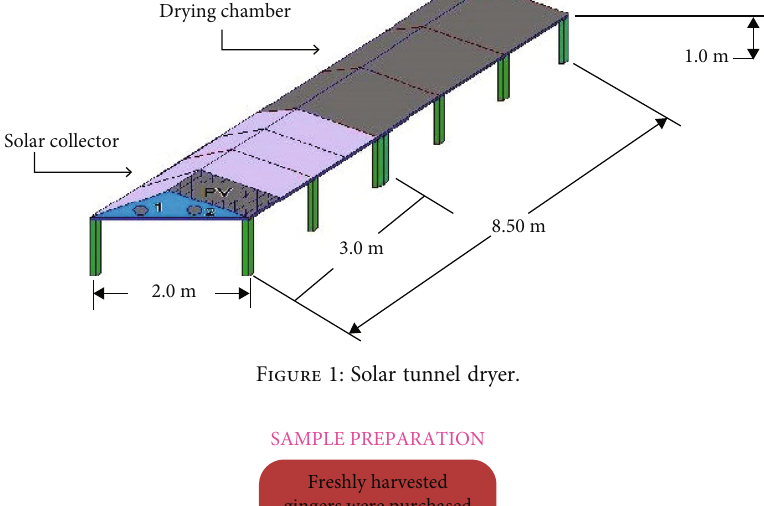
Figure 1: Solar tunnel dryer.